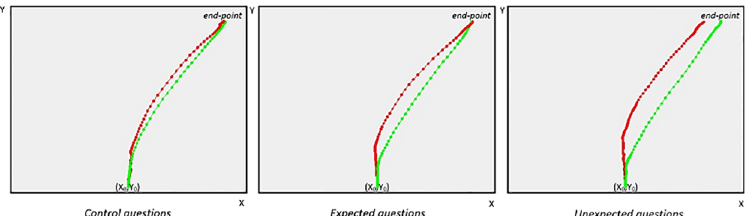
Fig 4. Trajectories for control, expected, and unexpected questions. Mouse trajectories for control questions(left), expectedquestions(center), and